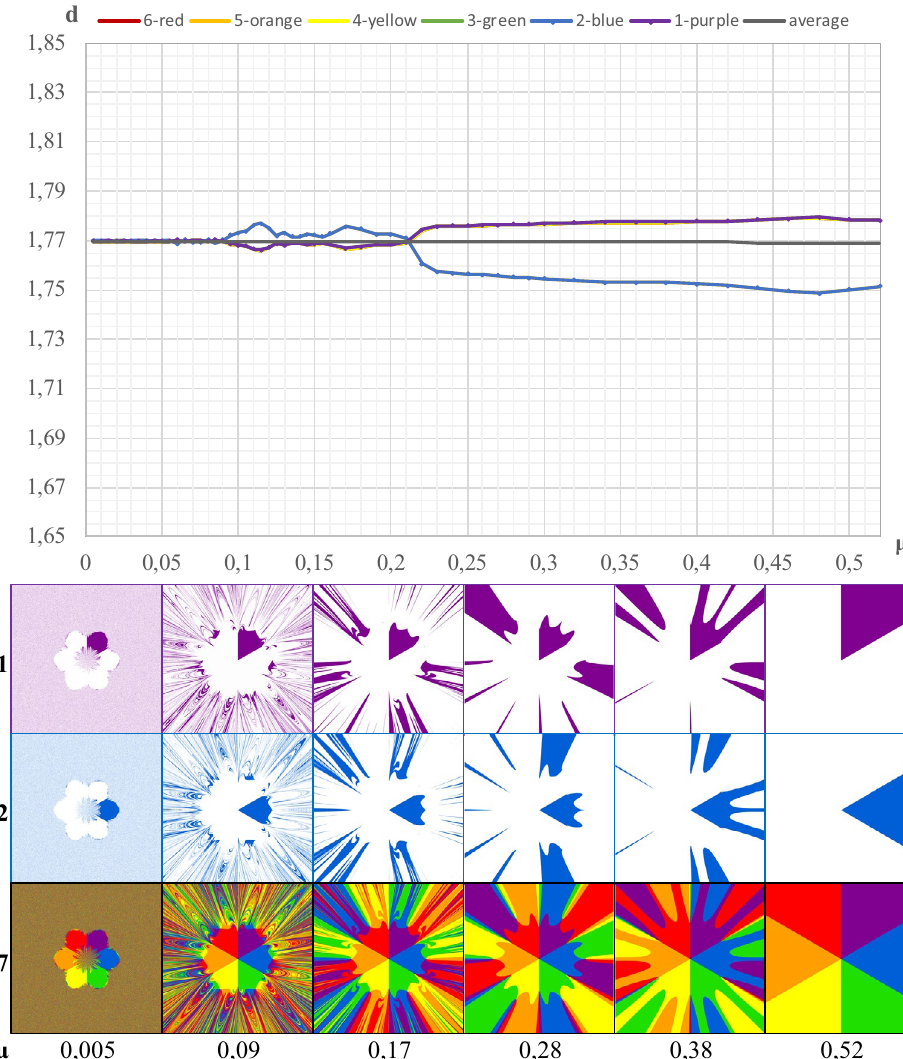
Figure 5. Box dimension of the attraction basins as a geometric irregular figure in the gravitational fractal. Legend: 1-basins of the first city, 2-basins of the second city, 7-basins of all